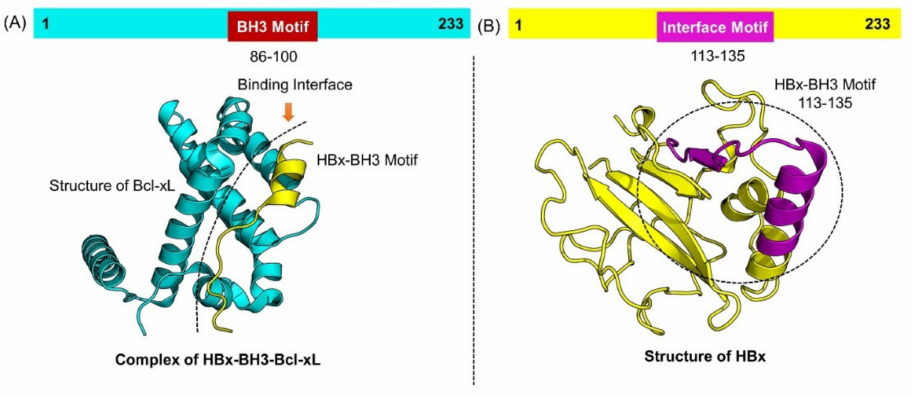
Figure 1. ( A ) Structure of Bcl-xL in complex with the interacting motif from HBx shown in cyan and magenta color. ( B ) Represents the modeled structure of HBx while the interface motif is shown as